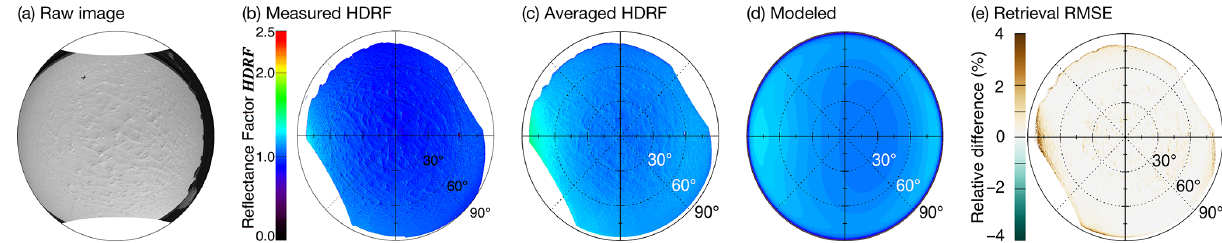
Figure 4. Exemplary post-processing and retrieval of model parameters for HDRF measurement. (a) Raw image taken on 2 January 2014 at 08:16UTC ( θ 0 = 58 . 9 ◦ ). (b) Polar plot of observed snow HDRF ρ l calculated from raw image for camera channel G. The image is rotated in the azimuthal direction of the Sun such that the Sun is on the left. (c) Averaged HDRF measurement using three images; the foot- print is 1670m. (d) Modeled snow HDRF R HDRF ,l after retrieval of model parameters f iso = 1 . 12, f vol = 0 . 17, and f geo = 0 . 01 from (c) . (e) Relative difference (ρ l − R HDRF ,l )/R HDRF ,l . The accumulated RMSE is